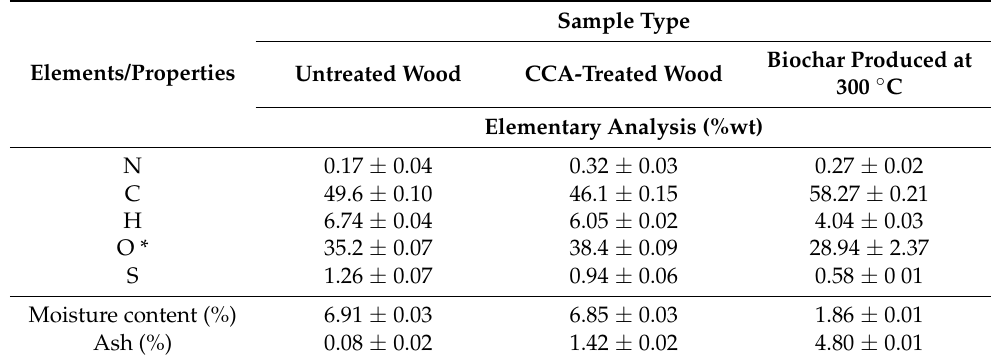
Table 2. Characterization of untreated wood, CCA-treated wood, and biochar.